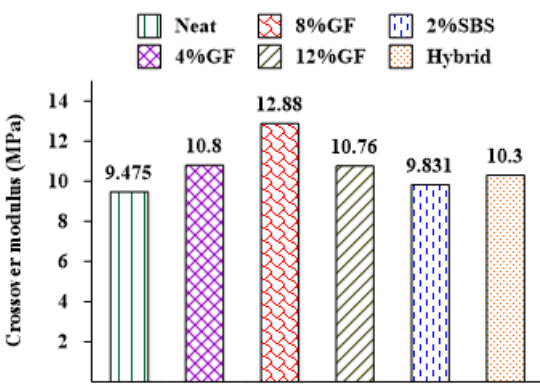
Figure 11. Additives’ influences on the crossover moduli of asphalt binders.